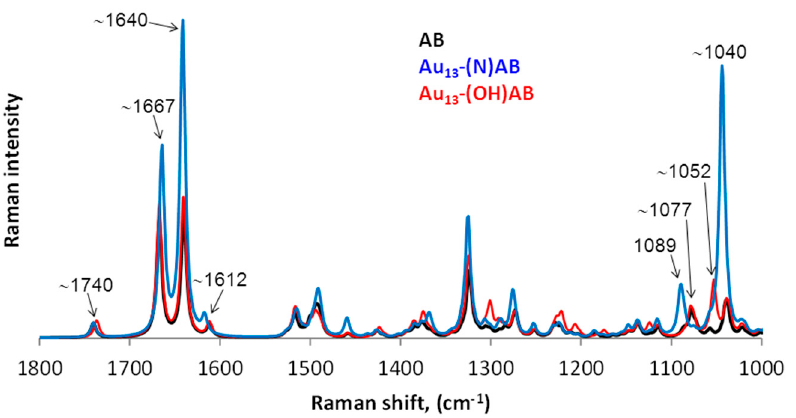
Figure 8. A comparison of the theoretical Raman spectra of AB, Au 13 –(N)AB, and Au 13 –(OH)AB in the range from 1800 to 1000 cm − 1 .